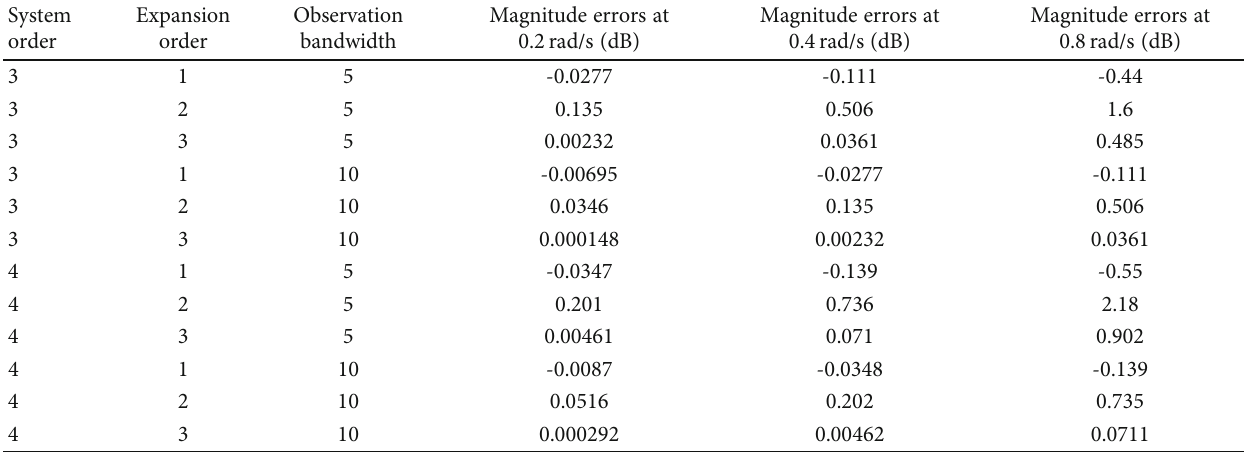
Table 1: Magnitude errors of high-order LESO in the low-frequency band.